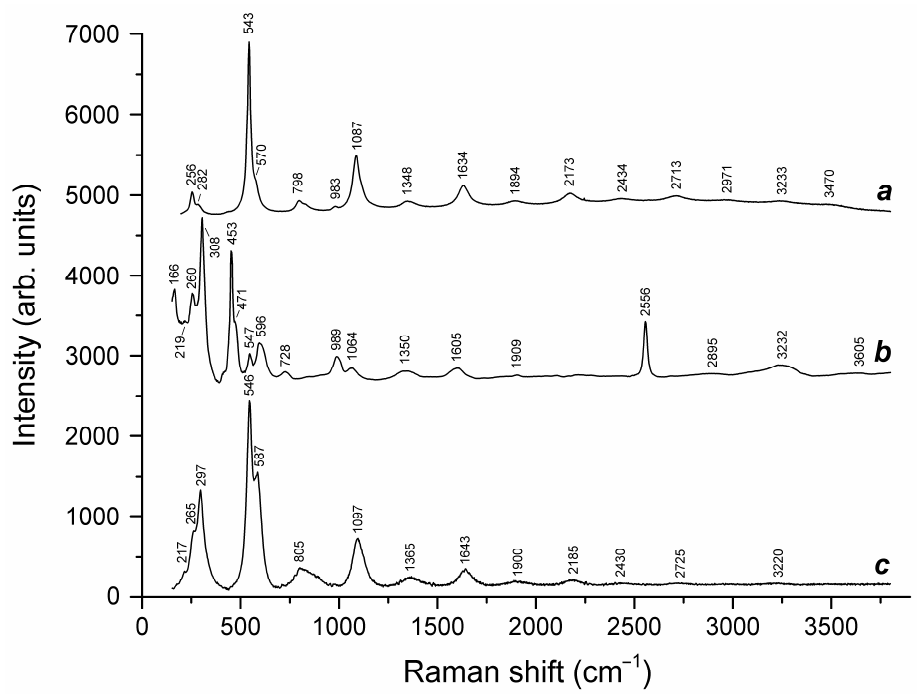
Figure 9. Raman spectra of ( a ) initial Sample 2, ( b ) Sample 2 preheated for three days at 700  C, over the Fe-FeS buffer, and ( c ) preheated Sample 2 additionally annealed at 800  C in air for one day.